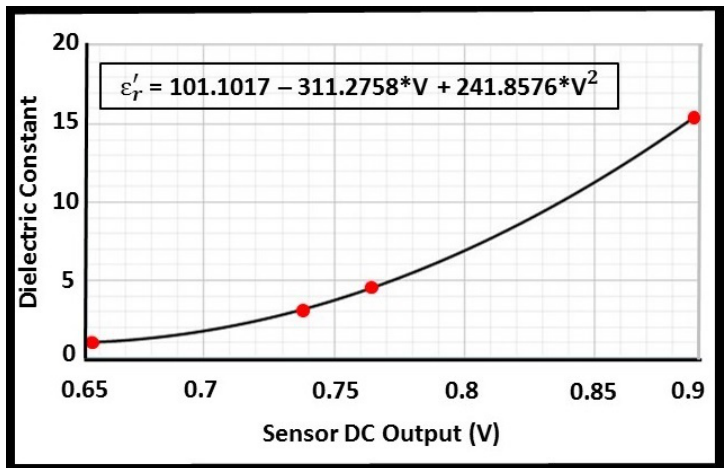
Figure 6. The fitted calibration line using the quadratic regression method. In the equation, V represents the corresponding DC output of the sensor in volt and ε (cid:48) r is the dielectric constant of the MUT.